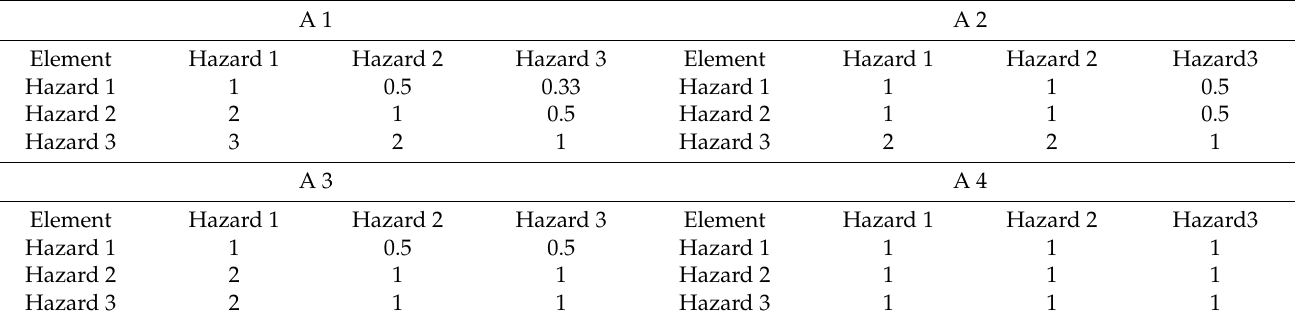
Table 5. The judgment matrices.